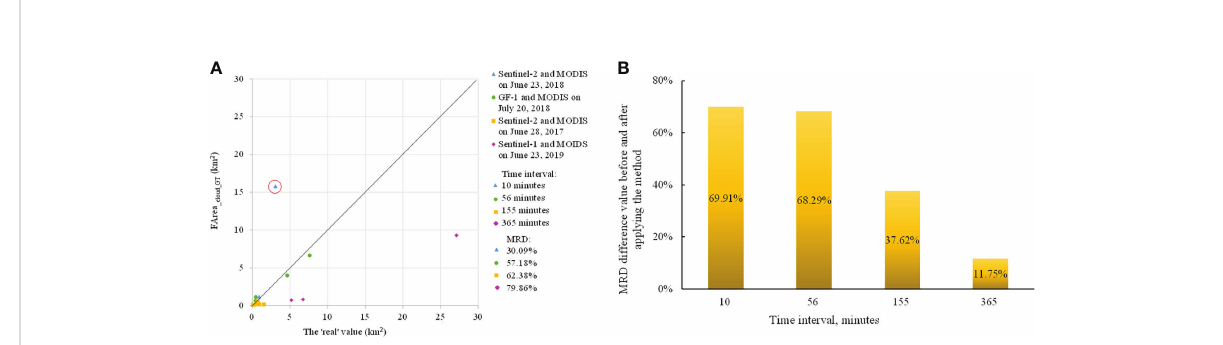
FIGURE 8 (A) The veri fi cation results of the simple method for estimating macroalgae area under clouds on MODIS imagery. The ‘ real ’ values are the macroalgae area detected by fi ne resolution images. FArea _cloud_GT is the macroalgae fi tted area converted by Area_cloud_GT, and Area _cloud_GT is the macroalgae area under clouds estimated by the method. The black line in fi gure is the 1:1 line. (B) The MRD difference value before and after applying the